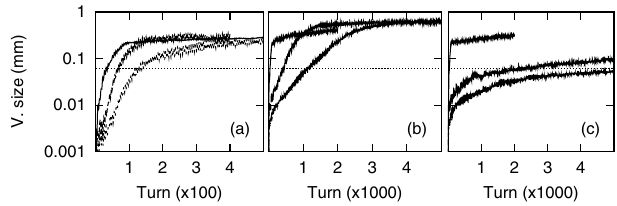
FIG. 35. Growth of the vertical rms amplitude of the micro- bunches without synchrotron motion (left), with synchrotron (cid:8) (cid:4) 4 ; 8 (cid:5) (center), and for zero motion and chromaticity Q 0 x;y chromaticity (right) [28]; the three curves refer to electron densities of 2 (cid:1) 10 11 , 4 (cid:1) 10 11 , and 10 12 m (cid:2) 3 ; the growth is faster for higher density; the dashed line indicates the natural rms beam size.